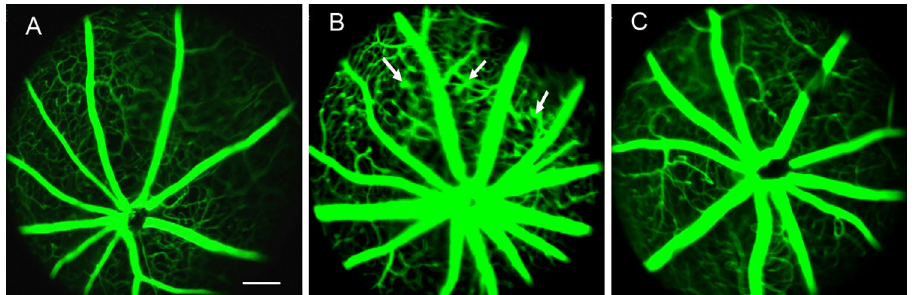
Fig 3. Representative FFA images. (A) Normal; (B) Diabetic; (C) Diabetic treated with ATWLPPR. Arrows: fluorescence leakage areas. Bar = 300 μ m.